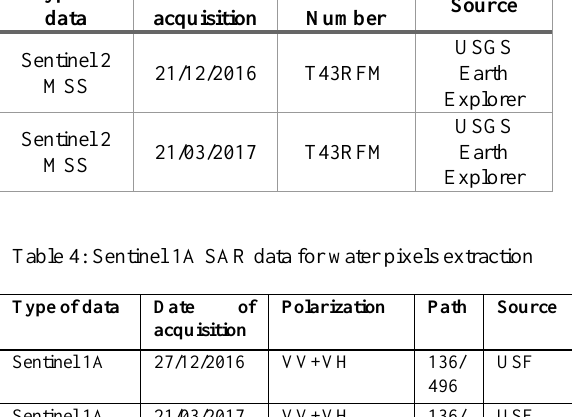
Table 3: Sentinel 2 MSS data for water pixels extraction Type of